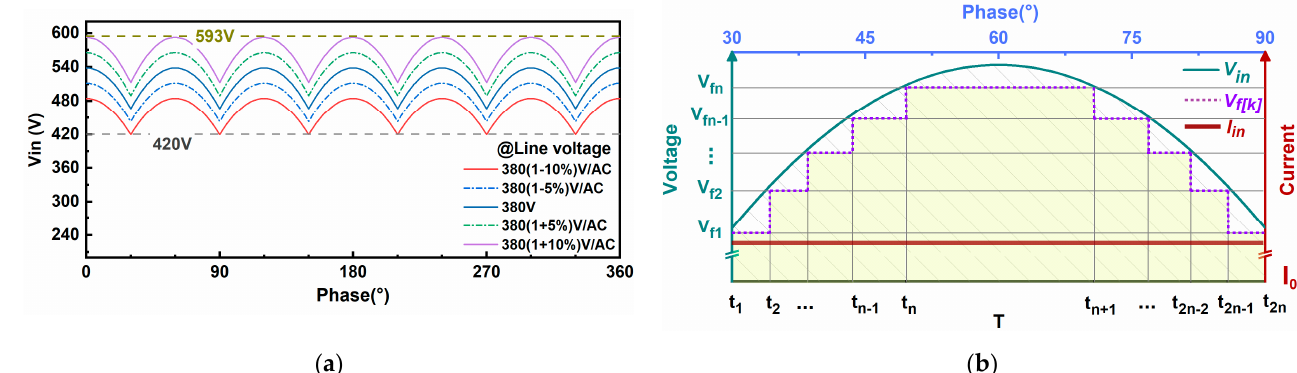
Figure 3. ( a ) V in within ± 10% tolerance. ( b ) Schematic diagram of V in , V f[k] , and I in . Figure 3. ( a ) V ± 10% tolerance. ( b ) Schematic diagram of V in within